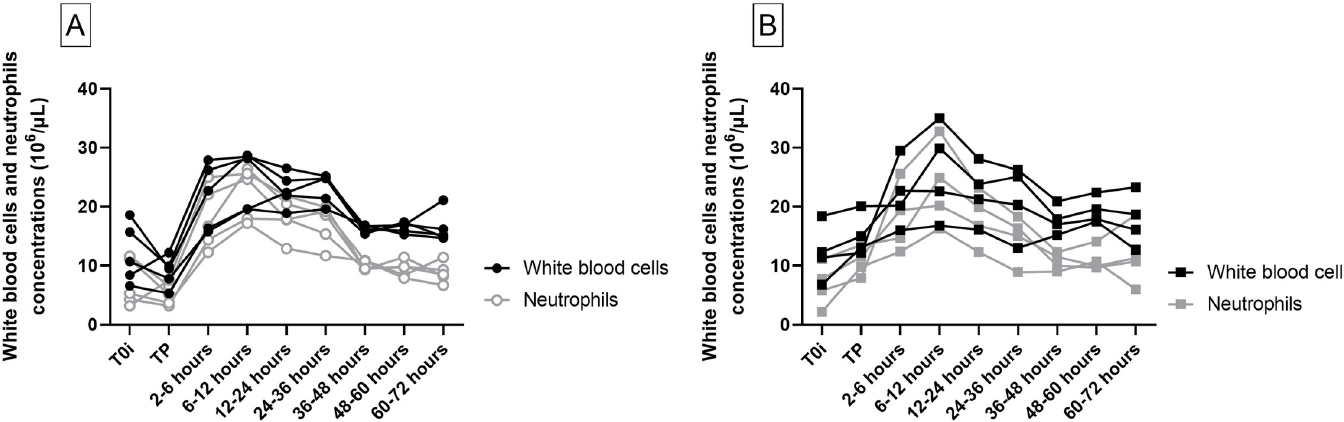
Fig 4. WBC and neutrophil counts in the visceral model (A, n = 5) and the cardiac model (B, n = 4). Each line represents one animal. The different times of sampling are during anesthesia before blood loss (T0), after autologous transfusion at the end of anesthesia (TP), then during the 72 h survival follow-up period (7 sampling times following the end of the